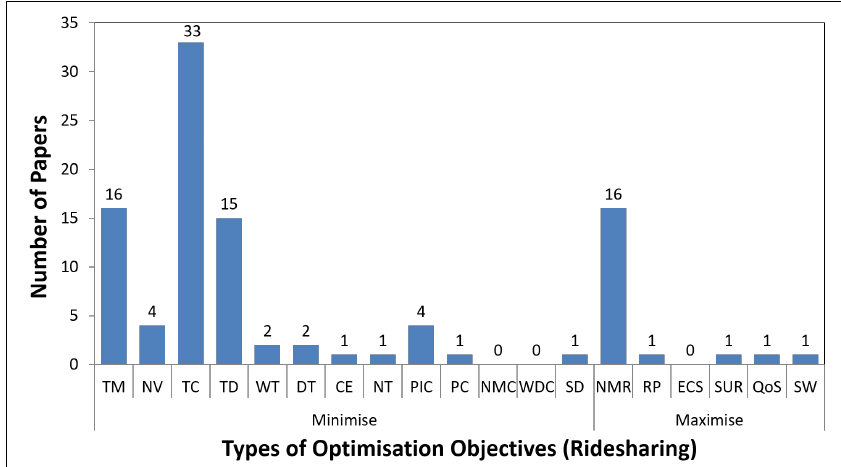
Figure 13. Distribution of Papers based on the Optimisation Objectives: Ridesharing.